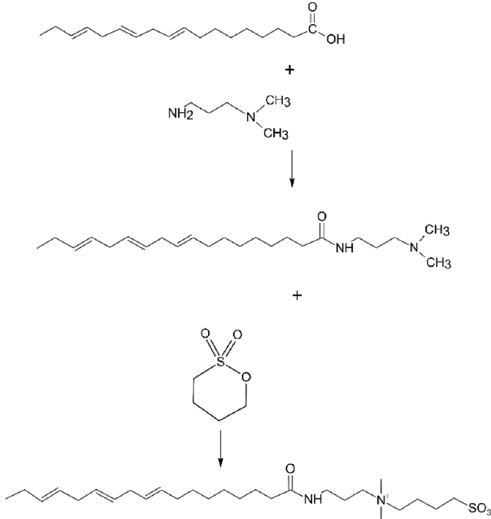
Figure 5. Synthesis route of Evening Primroseamidopropyl Sulfobetaine: 1H NMR (D2O) σ = 0.859 (3H, CH3), 1.218 − 1.286 (18H, CH2), 1.503(4H, CH2), 1.890 (4H, CH2), 2.188 (2H, CH2), 2.872 (6H,